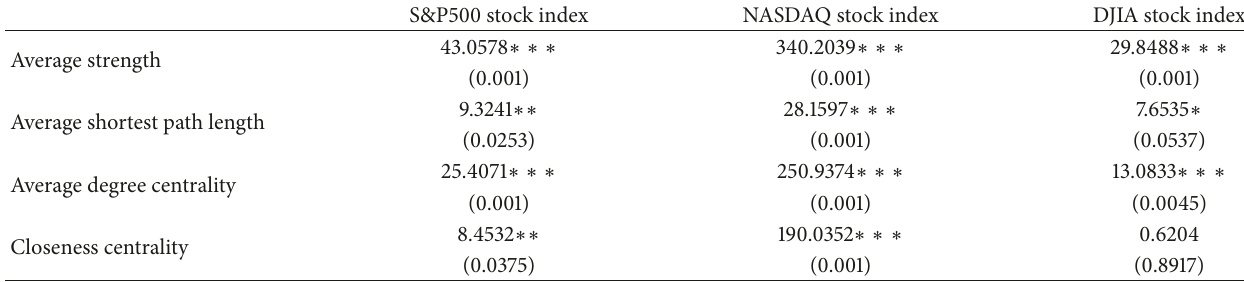
Table 2: Kruskal–Wallis tests of the four network topological characteristic variables and next-day patterns of each stock index.